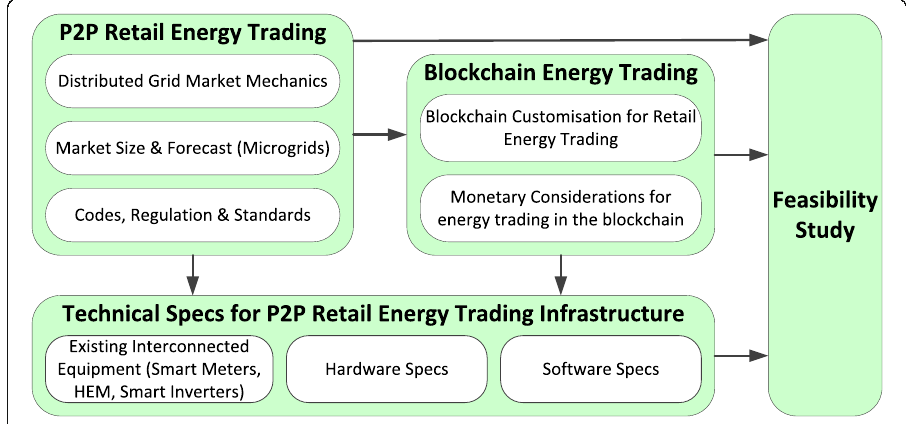
Fig. 1 Key aspects of the EnerPort